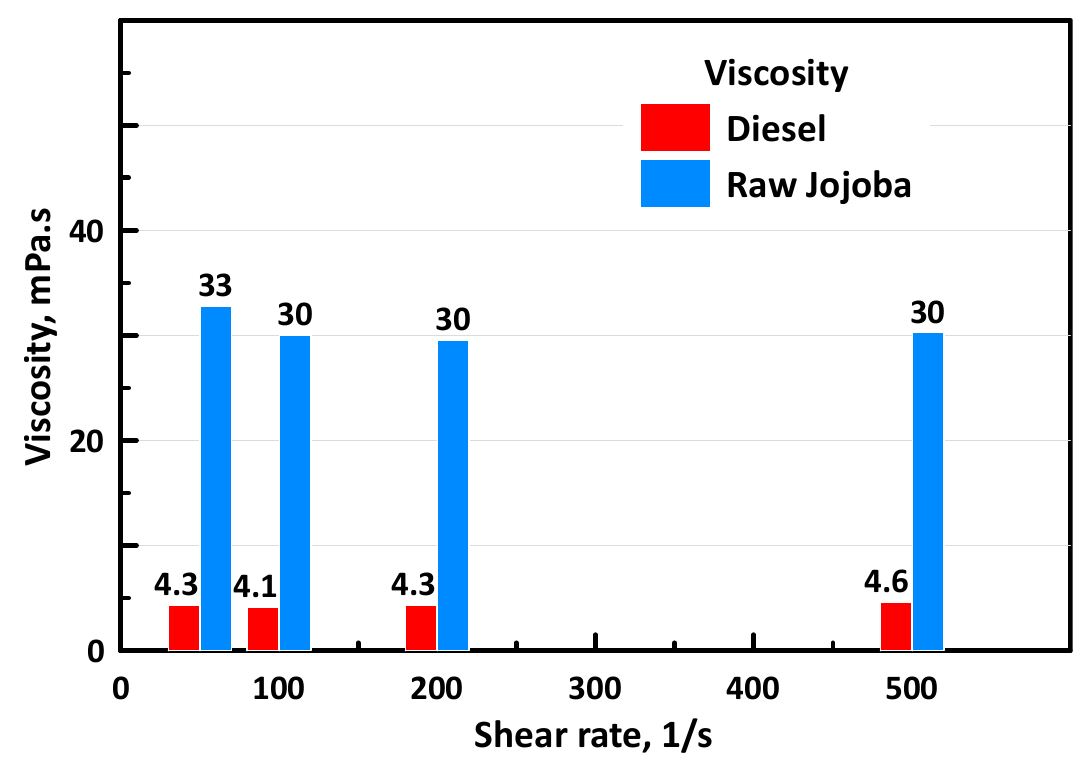
Figure 1. Viscosities of raw Jojoba oil compared to diesel at four shear rates, at 30 °C.